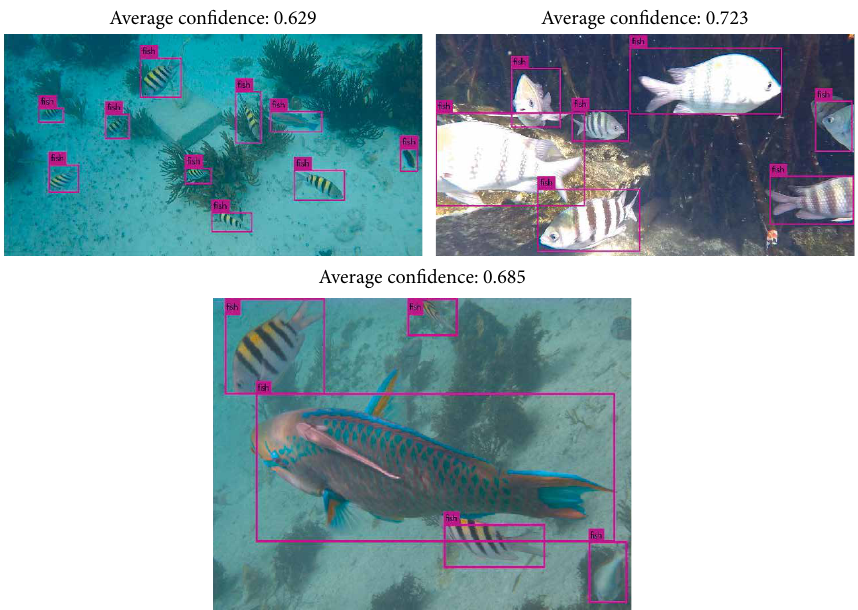
Figure 17: Enhancement of identification accuracy with dropout.